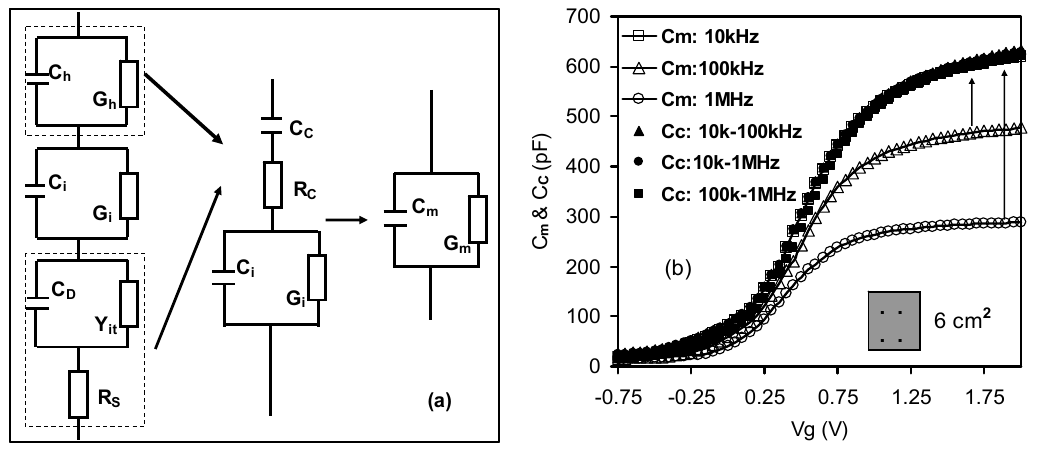
Figure 10. Effect of the lossy interfacial layer on high -k stacks. ( a ) Four-element equivalent circuit model for high -k stacks, taking into account the presence of the interfacial layer with the additional capacitance, C , and conductance, G , parallel circuit i i components. C and G represent the actual capacitance and conductance across the high -k h h dielectric. C is the depletion capacitance and Y is the admittance due to interface states, D it respectively; ( b ) Extracted C -Vg curves based on dual-frequency data from Figure 3 and C the equivalent circuit model from Figure 10a